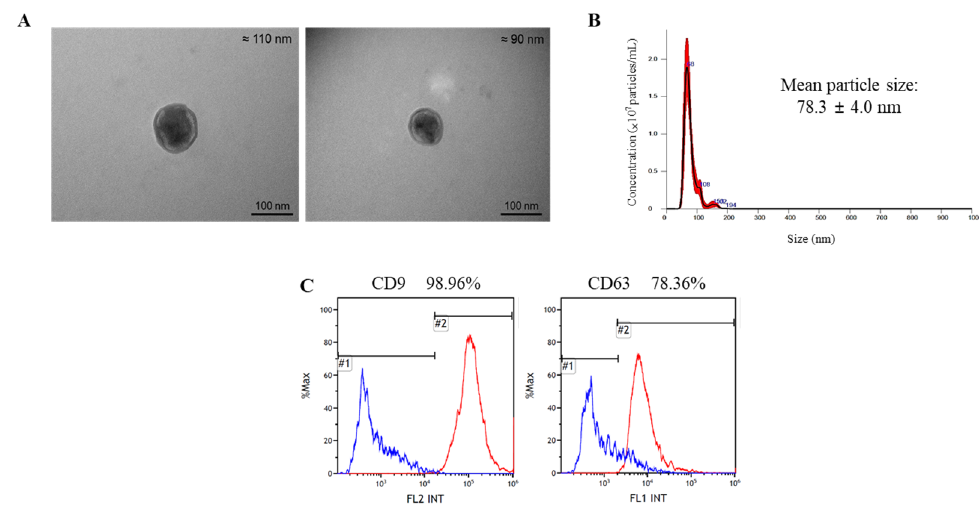
Figure 4. Characterization of total exosomes (tEVs) isolated from serum: ( A ) Transmission electron microscopy (TEM) images showing exosome morphology and size. Scale bar: 100 nm; ( B ) Nanoparticle tracking analysis (NTA) of exosomes to confirm size distribution; ( C ) Flow cytometry (FACS) data confirming the detection of exosome markers (CD9 and CD63).